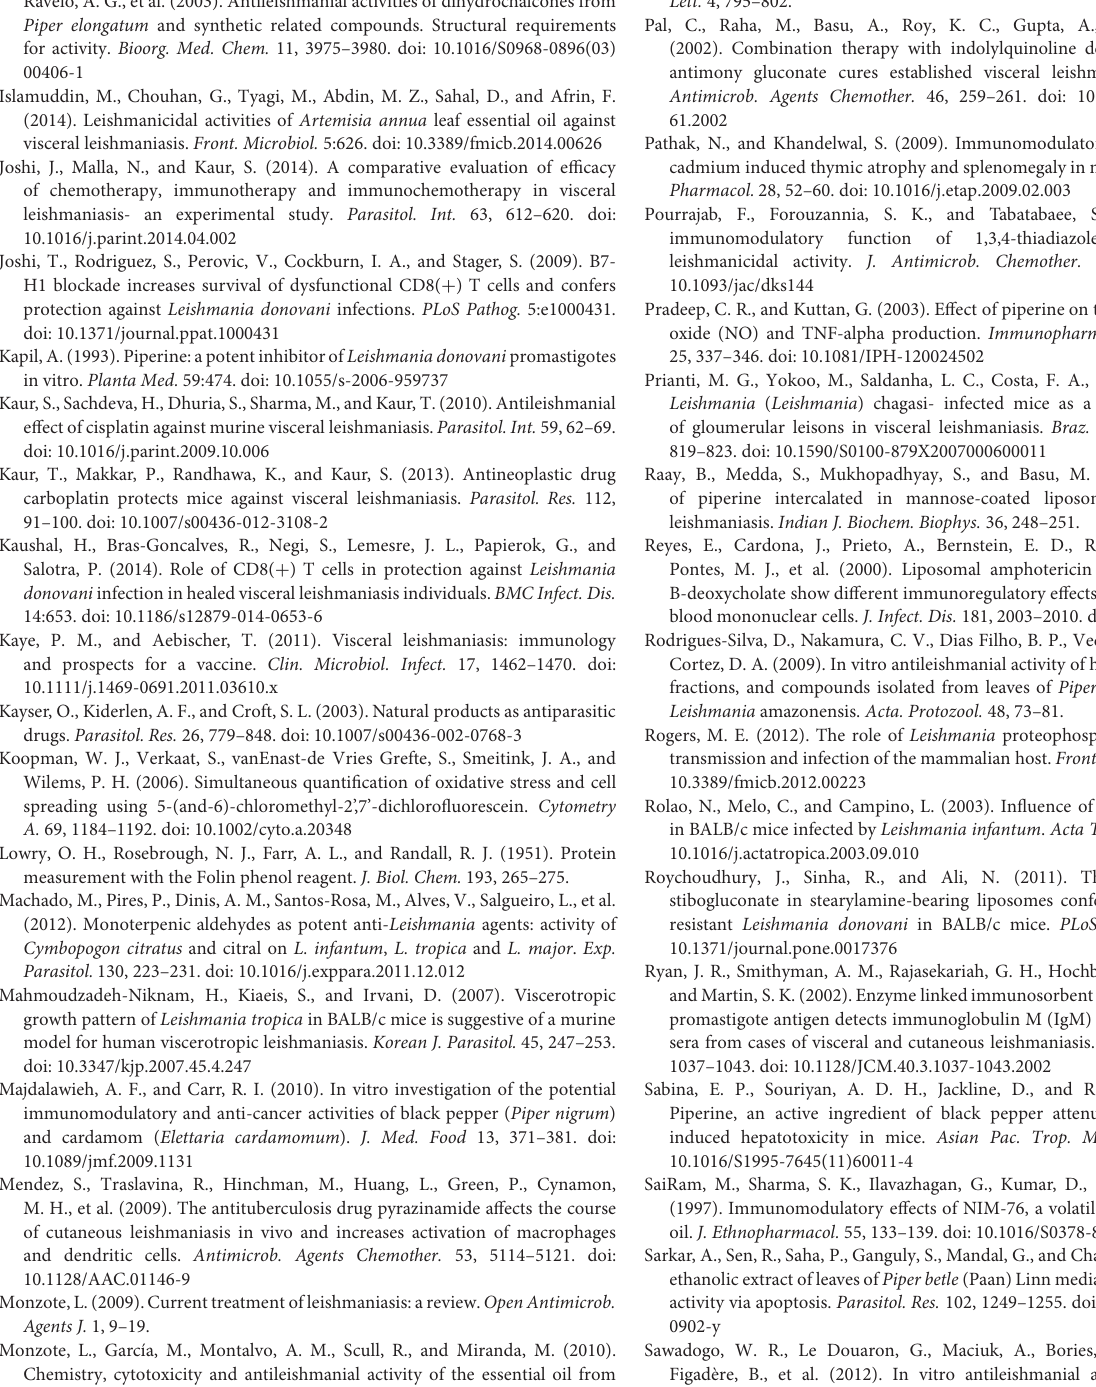
Figadère, B., et al. (2012). In vitro antileishmanial and